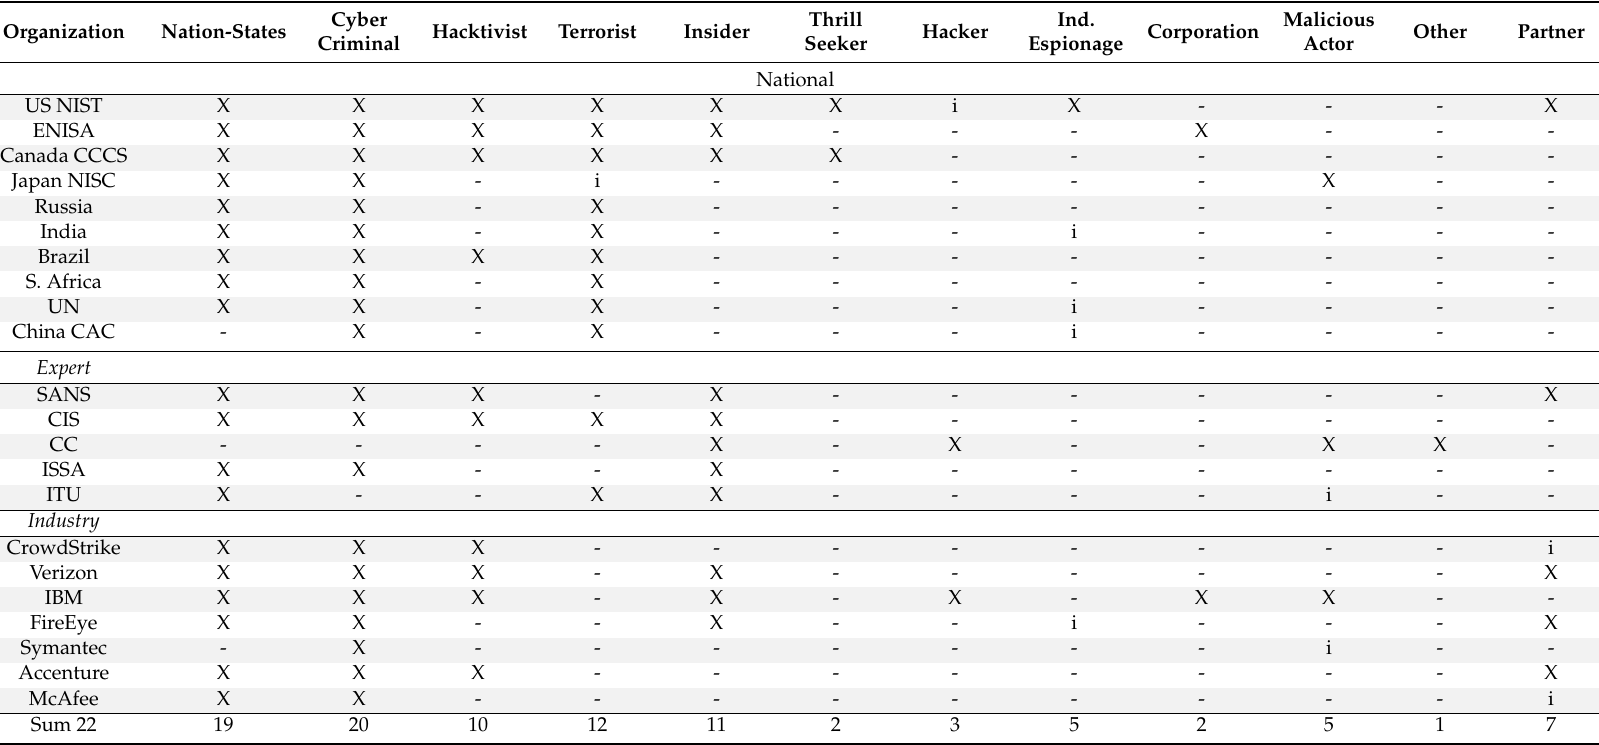
Table 1. List of identified cyber threat actors (CTAs) based on international reports and strategy